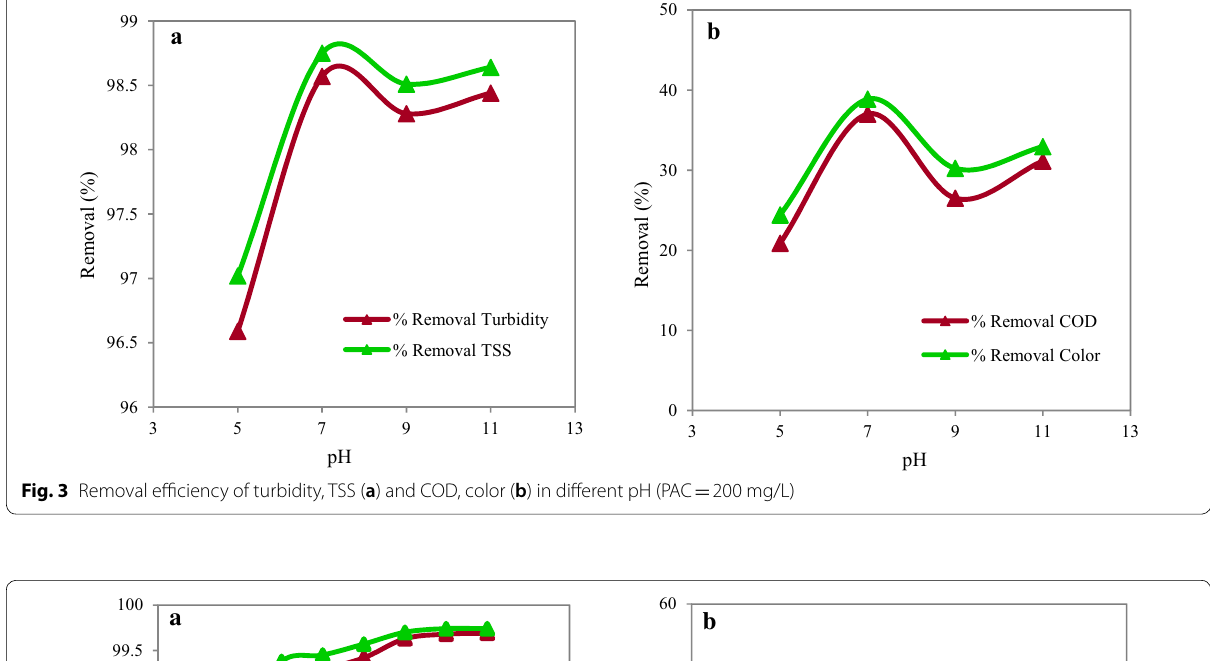
Fig. 3 Removal efficiency of turbidity, TSS ( a ) and COD, color ( b ) in different pH (PAC